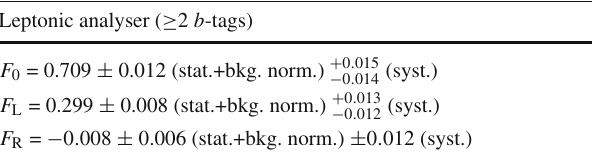
Table 2 Measured W boson helicity fractions obtained from the lep- tonic analyser including the statistical uncertainty from the fit and the background normalisation as well as the systematic uncertainty Leptonic analyser ( ≥ 2 b -tags) F 0 = 0.709 ± 0.012 (stat.+bkg. norm.) + 0 . 015 − (syst.) 0 . 014